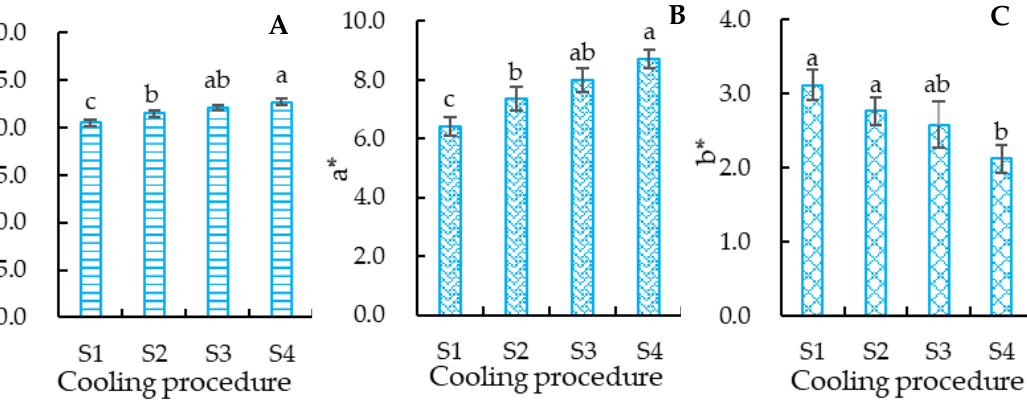
Figure 4. Effects of cooling speed on the color of the crucian carp meat. ( A ) Brightness value (L*); ( B ) redness value (a*); ( C ) yellowness value (b*). S1: treated with cooling speed of 5 °C/h followed by 1 °C/h; S2: treated with cooling speed of 3 °C/h followed by 1 °C/h; S3: treated with cooling speed of 2 °C/h followed by 1 °C/h; S4: control. Different letters above the standard deviation represent significant differences between the groups ( p < 0.05).